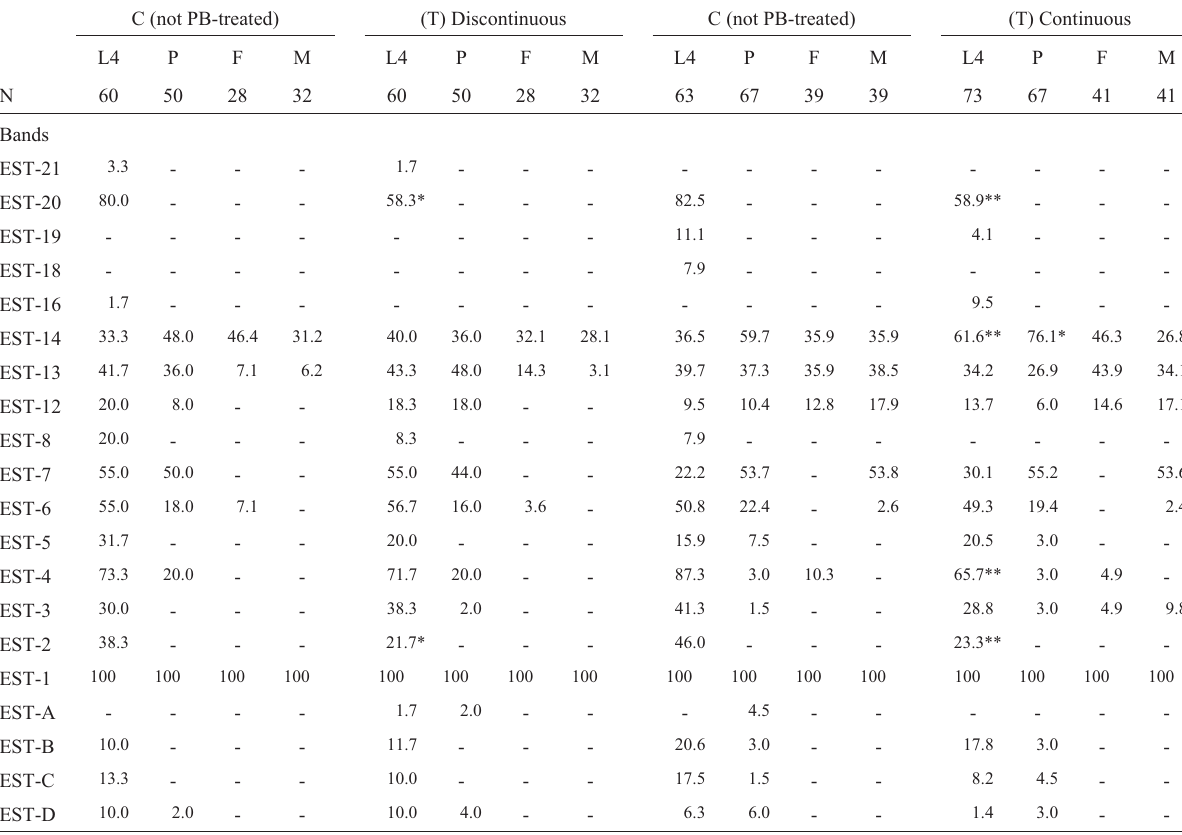
Table 4 - Effect of PB-treatment on esterase patterns. Percentage of A. aegypti mosquitoes from São José do Rio Preto submitted to continuous and discontinuous treatments (T) with phenobarbital (PB) and controls (C) bearing the esterase bands during different developmental stages. C (not PB-treated)